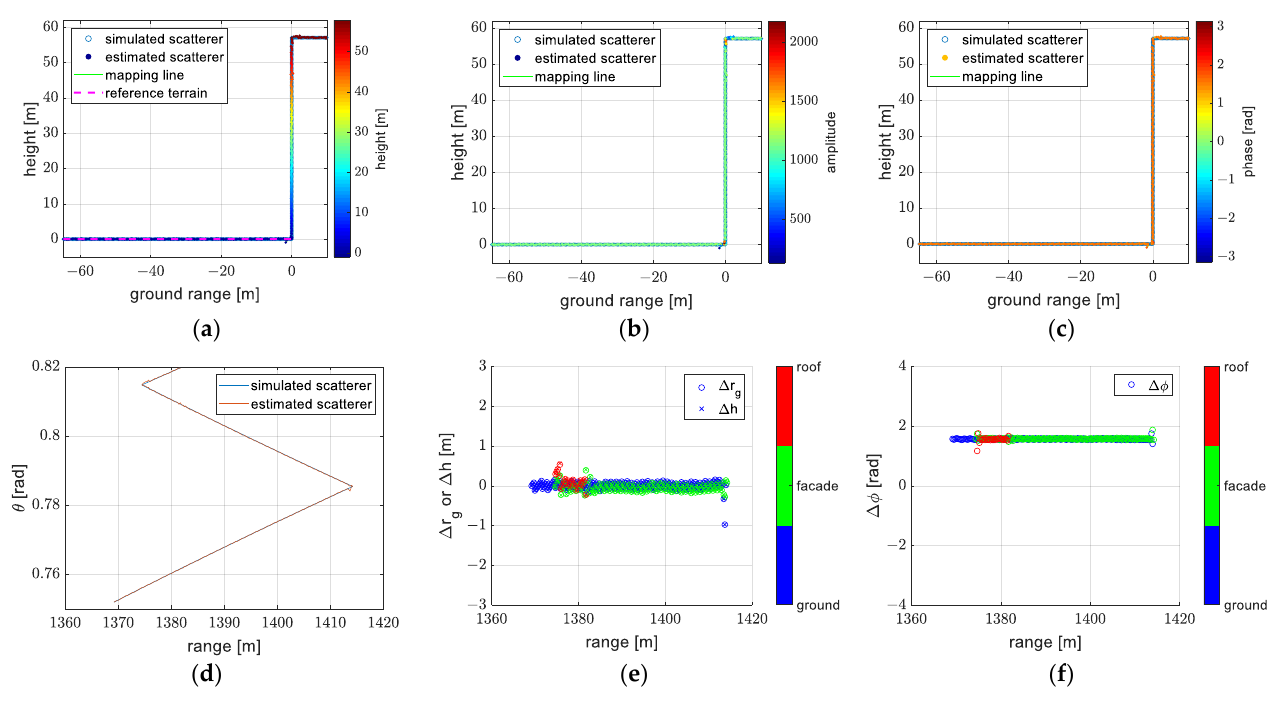
Figure 14. The reconstruction obtained using model 5 (the exact form of the spherical wavefront model): ( a ) reconstruction with colors denoted as height, ( b ) reconstruction with colors denoted as amplitude, ( c ) reconstruction with colors denoted as phase, ( d ) the off-nadir angle of the reconstruc- tion, ( e ) the error of the ground range and height, ( f ) the error of the phase.